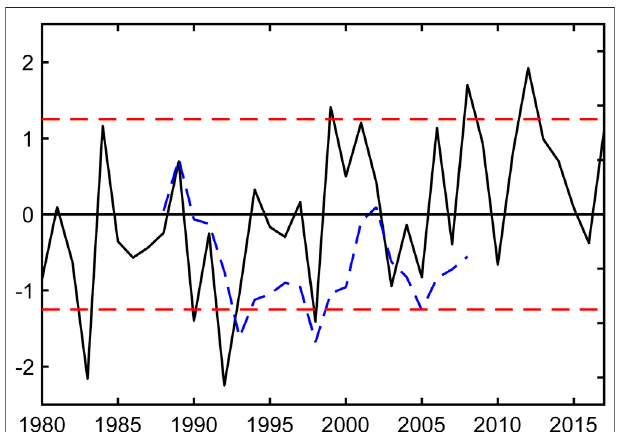
FIGURE 4 | Normalized time series of the 500 – 200 hPa mean MTG (TN – TS, red dashed line) between the northern domain (20 ° – 25 ° N, 105 – 120 ° E) and the southern domain (2.5 ° S – 2.5 ° N, 105 ° – 120 ° E) of the SCS (as the boxes named “ North ” and “ South ” in Figure 2C , respectively) and the SCSSM onset date (black solid line) during 1980 – 2017.